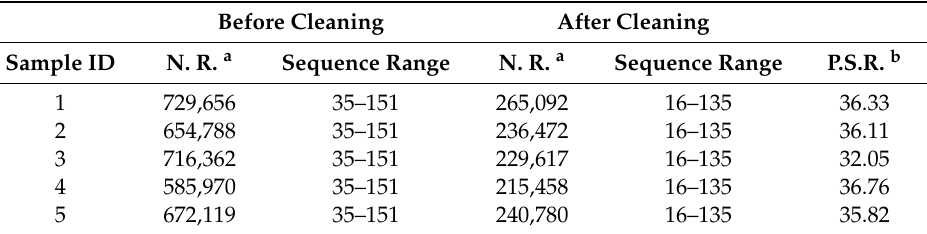
Table 3. Basic statistics before and after cleaning for a subgroup of